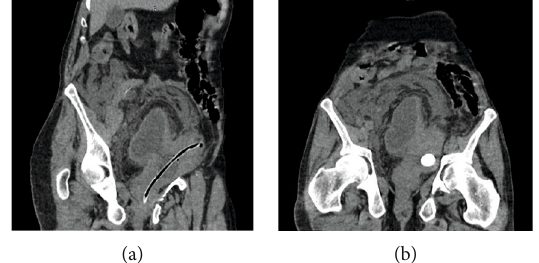
Figure 2: (a, b) Coronal oblique reconstruction of the CT scan showing collapsed bladder with a large diverticulum arising from the right superolateral bladder wall, with a large bladder stone and Foley catheter in place, associated to a small amount of free fl uid in the peritoneal cavity and around the diverticulum, with an enlarged prostate gland.